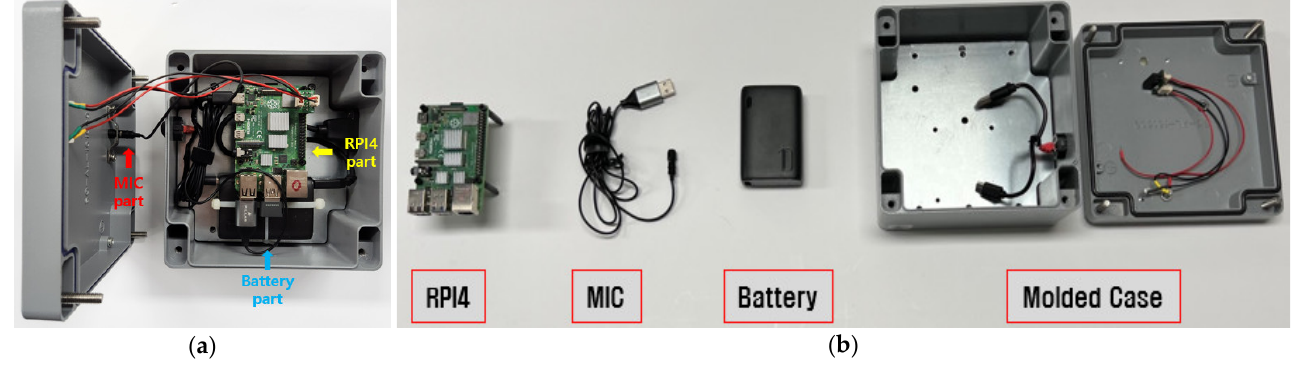
Figure 11. Internal structure of embedded system devices as: ( a ) embedded system internal structure; ( b ) embedded system internal equipment.